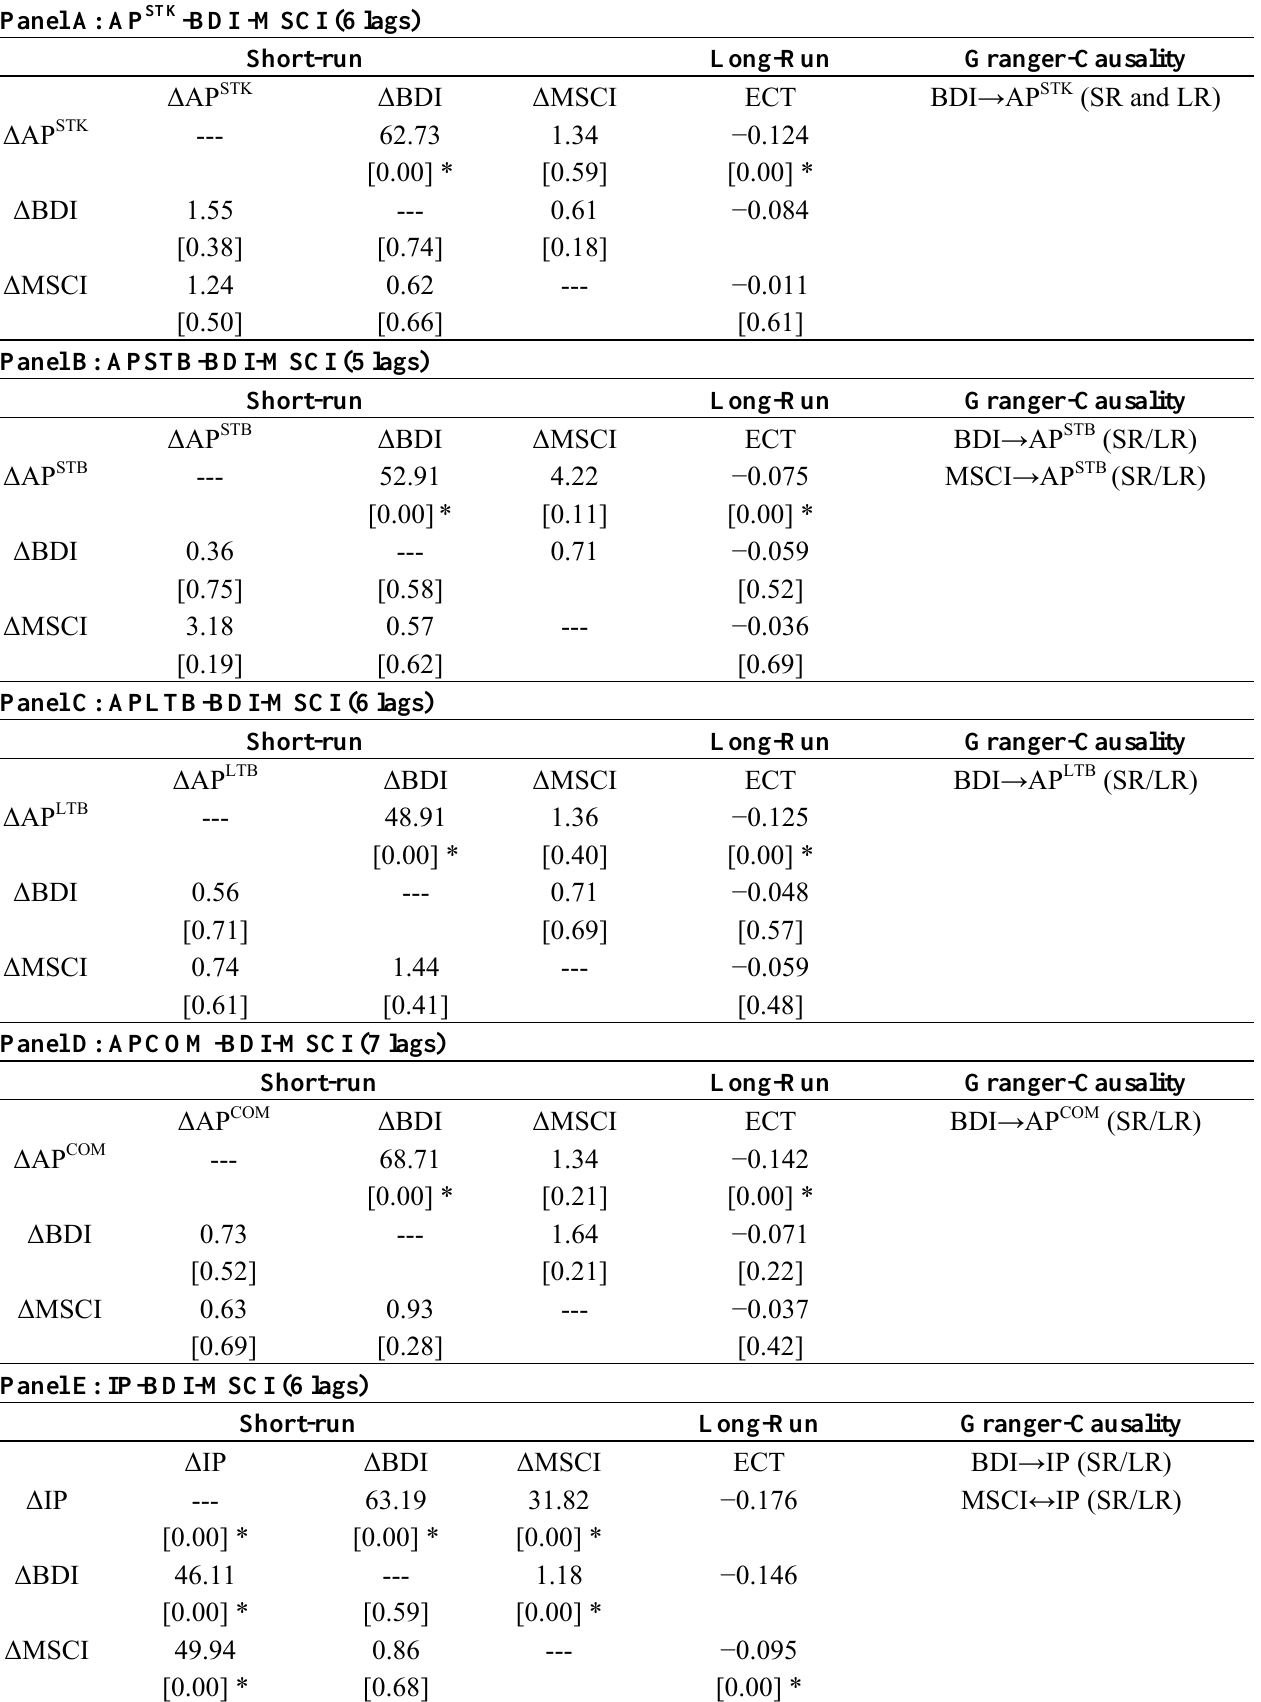
Table 7. Extended panel causality test